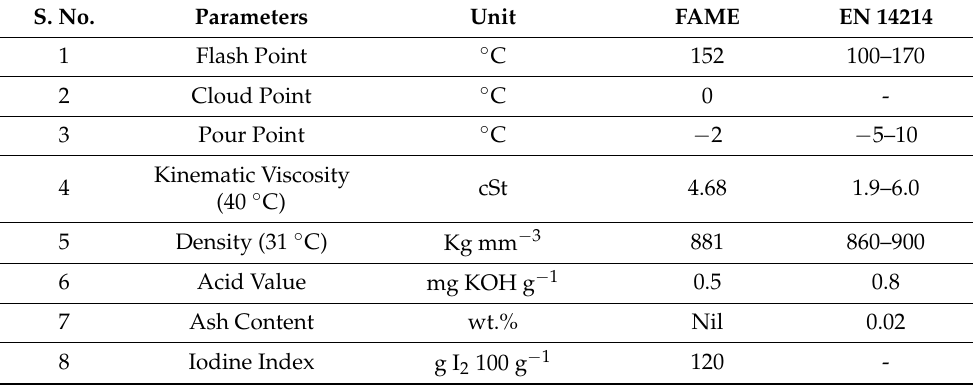
Table 2. The physicochemical properties of the biodiesel obtained from CF-biodiesel characterization. S.